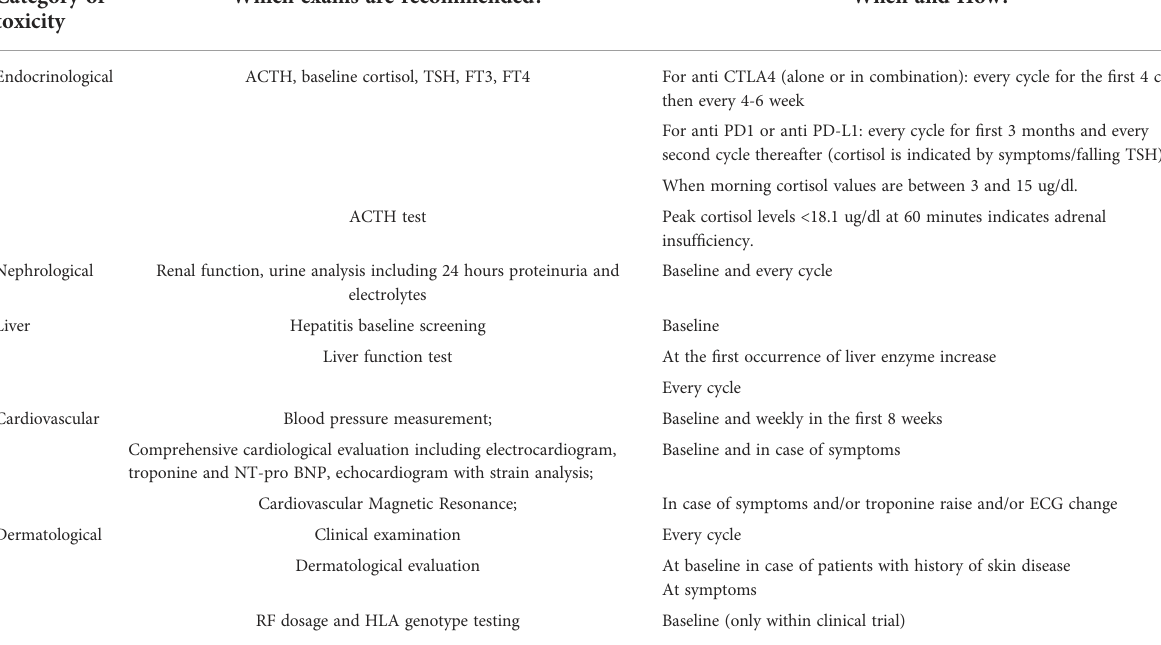
TABLE 1 The table summarizes our MDT suggestions and does not re fl ect any expert consensus or guideline: which exams are recommended by the experts to prevent and identify any adverse event? Category